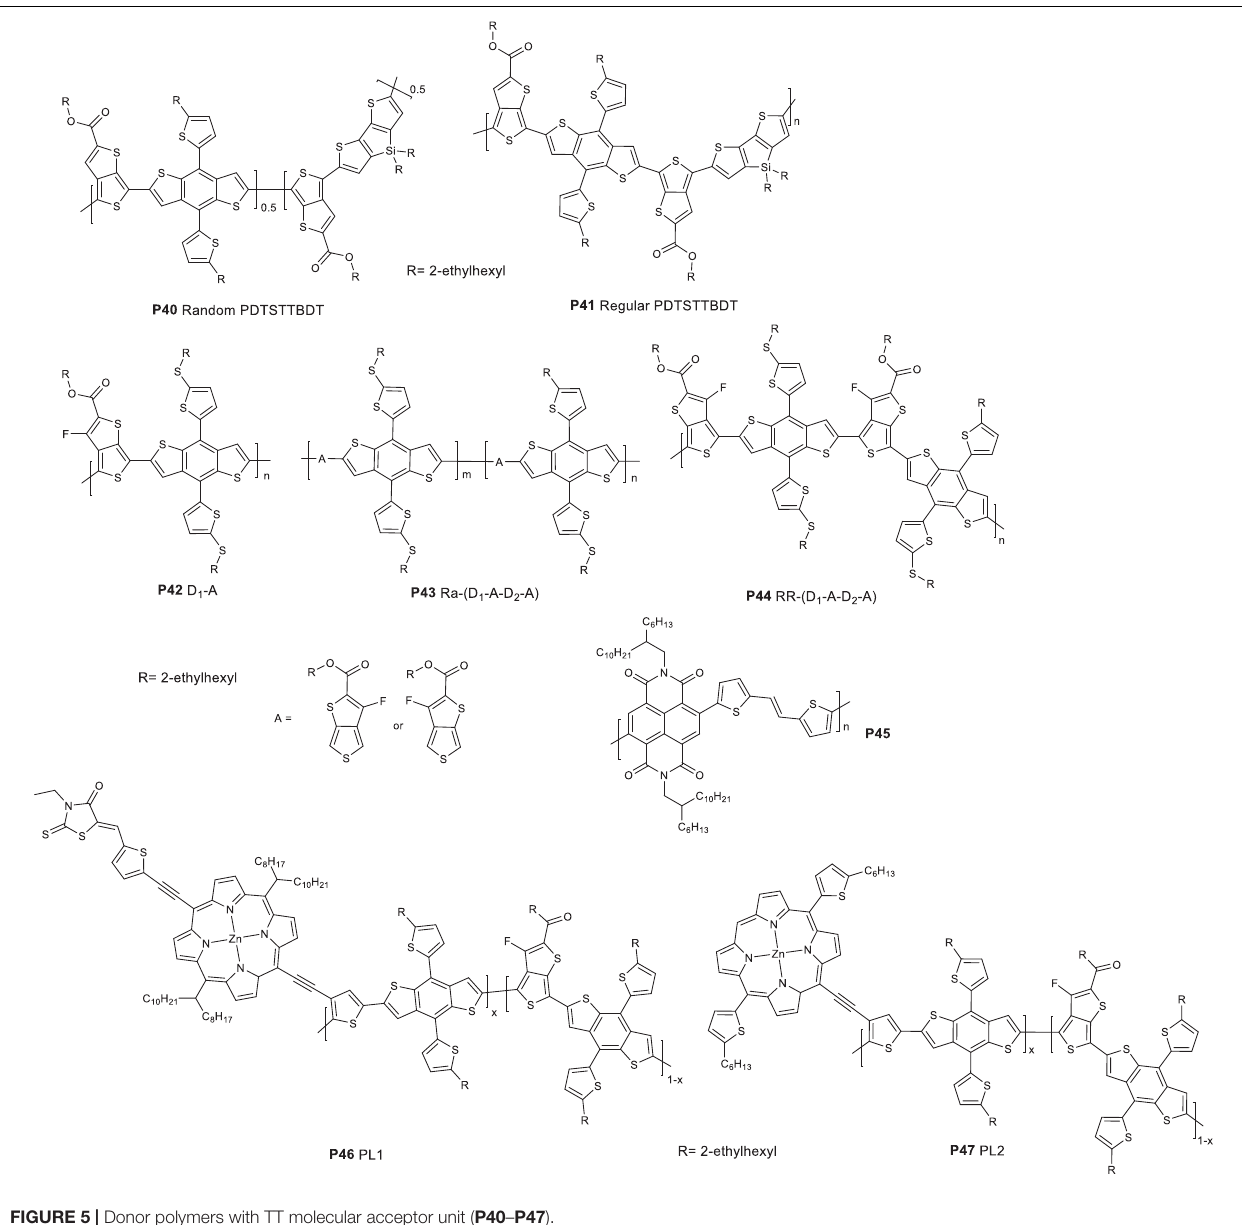
7.14% PCE for the devices based on P46 and P47 , respectively, after processing the film with chlorobenzene and 1.5% DIO